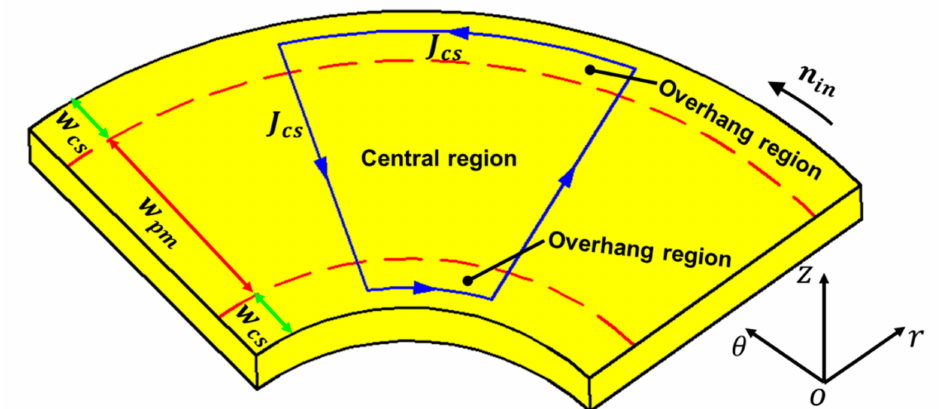
Figure 11. The real eddy current paths on the